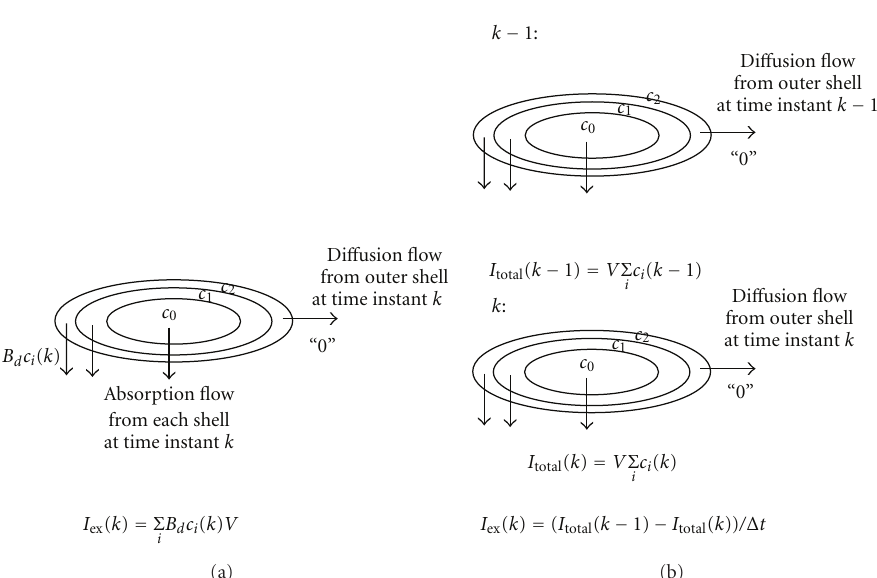
Figure 4: Two methods of approximation of the absorbed insulin flow: (a) the absorbed insulin flow I ex is obtained as the collection of absorbed insulin at each shell; (b) the absorbed insulin is obtained as the decrement of total insulin per unit time. If the number of shells is adequate, the di ff usion flow from the outer shell is null and both methods are equivalent.